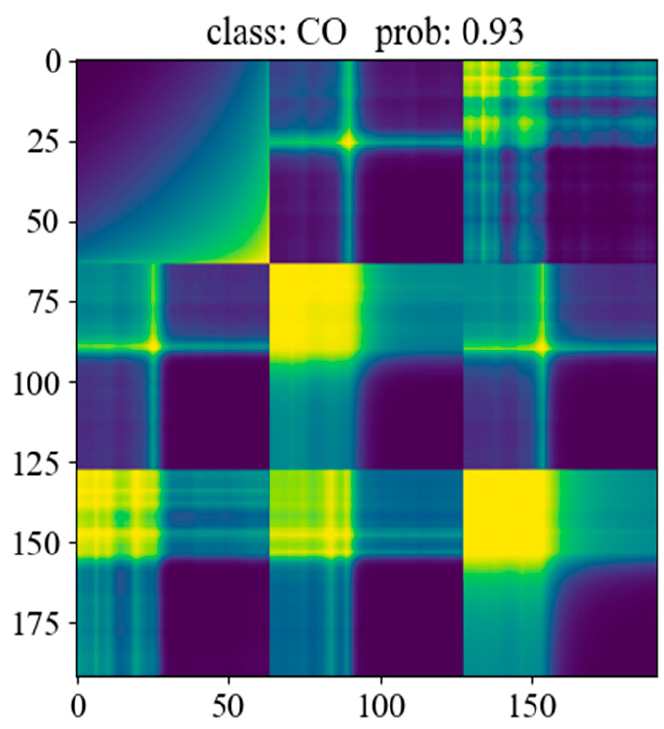
Figure 11. Gas identification and prediction results. The x and y axis represent the number of pixels converted from the gas sensing response data to the gas sensing image.